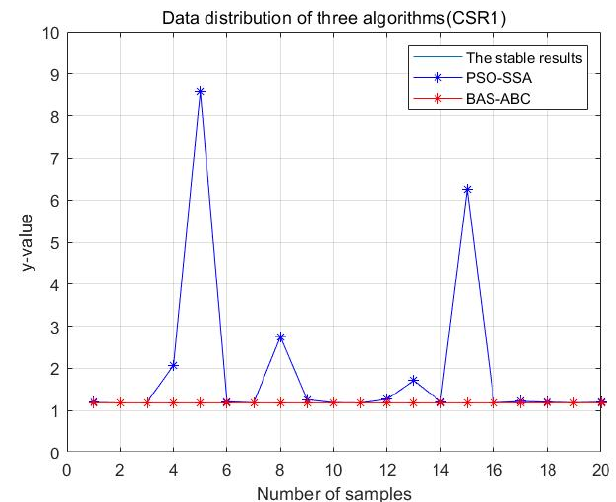
Figure 29. Data distribution—20 of two hybrid algorithms (SS3).